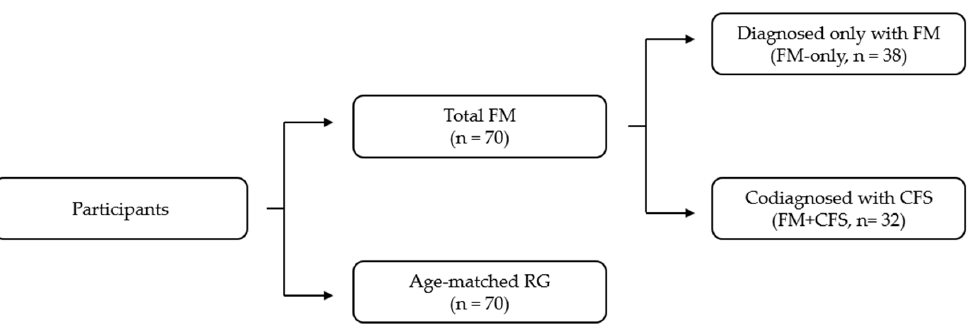
Figure 1. Flow charts of participants in the study. FM = Fibromyalgia, RG = Reference Group, CFS = Chronic Fatigue Syndrome.